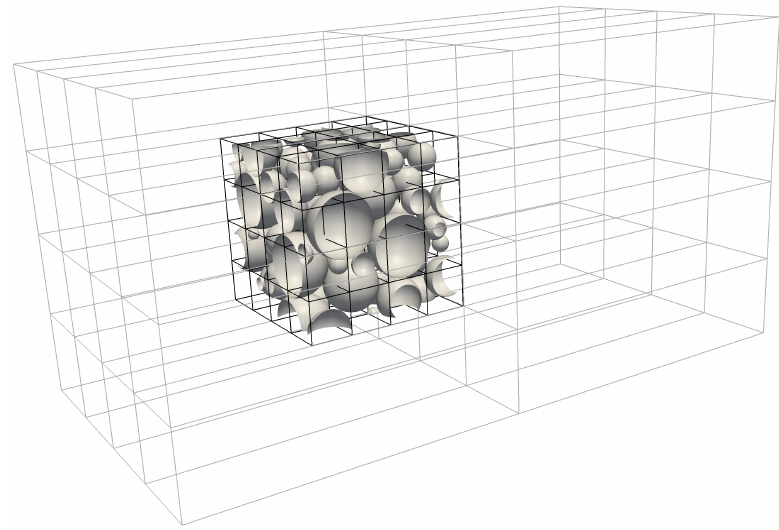
Figure 11. Channel flow with 100 random-sized rigid spherical obstacles forming a porous structure. The gray and black lines indicate the domain decomposition of NS and LB solver.